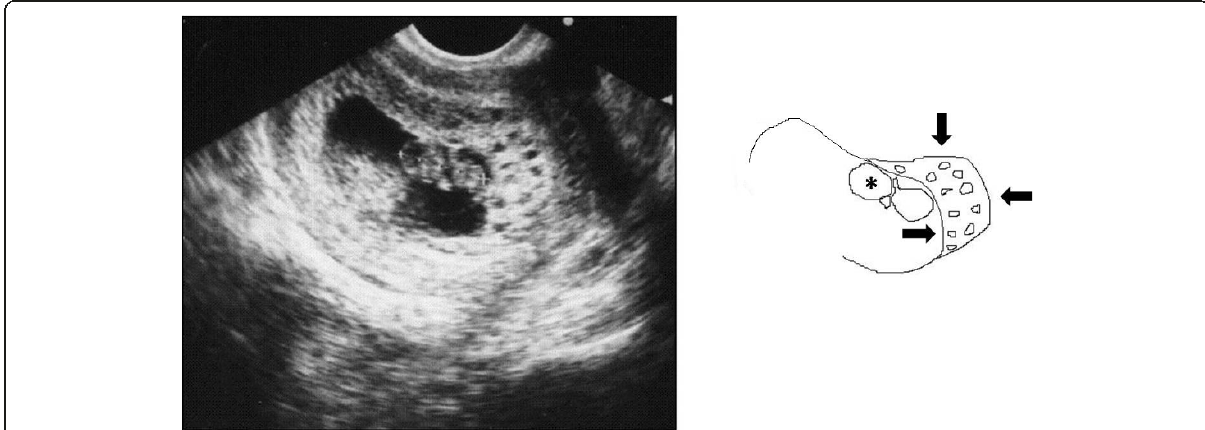
Figure 1 Transvaginal ultrasound study . An apparently normal fetus (asterisk) and villi with multiple hypoechoic cysts (arrows) at 8 weeks ’ gestation. Crown-rump length is 20 millimeters. Each cyst is 2-3 millimeters in